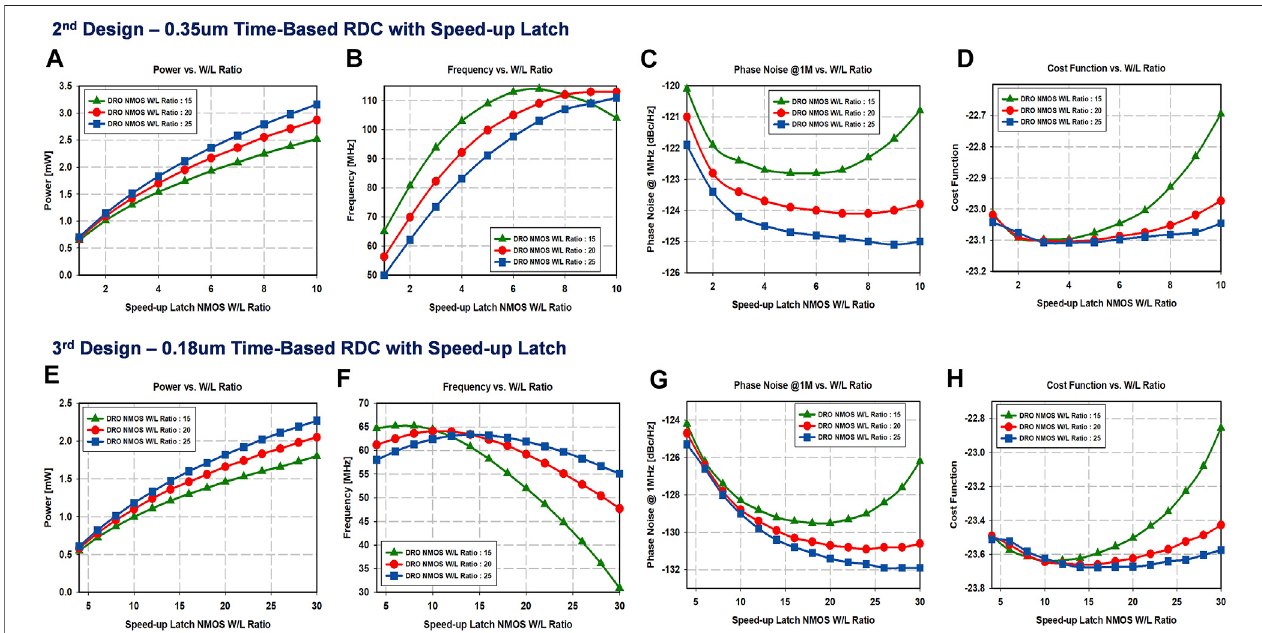
FIGURE 5 | Simulation results for the time-based RDC in 0.35 μ m and 0.18 μ m technology: (A) power (design 2), (B) frequency (design 2), (C) phase noise (design 2), (D) minimization cost function vs. sizing of the DRO transistors (design 2), (E) power dDesign 3), (F) frequency (design 3), (G) phase noise (design 3), and (H) minimization cost function vs. sizing of the DRO transistors (design